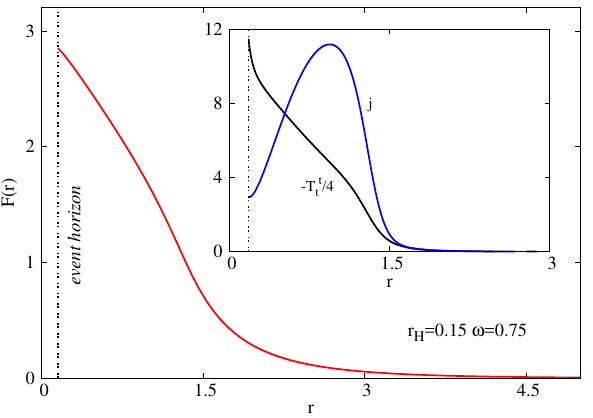
Figure 8 . The pro(cid:12)le of a typical Skyrme test (cid:12)eld solution on a given MP background is shown together with the corresponding energy and angular momentum